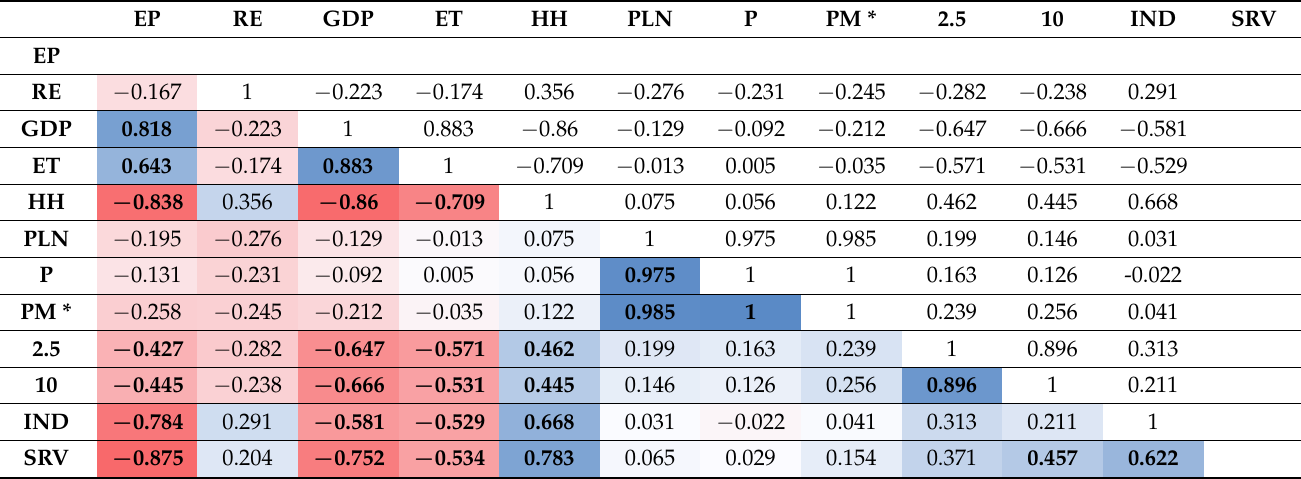
Table 4. Correlation matrix—Pearson coefficient.